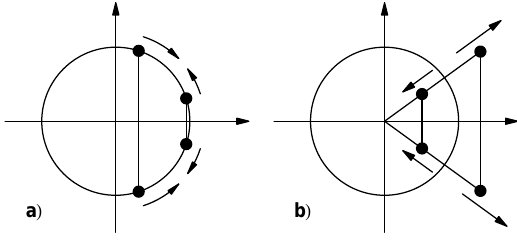
L Figure 3. Motion of the characteristic multipliers in the complex plane.